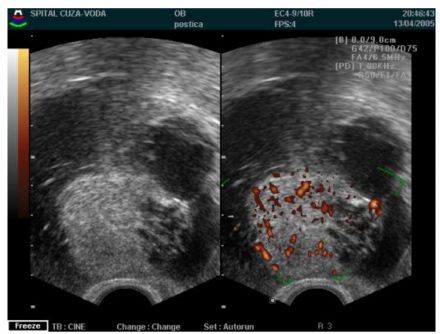
Figure 4. Doppler exam—intense vascularization in the core area of the tumor.